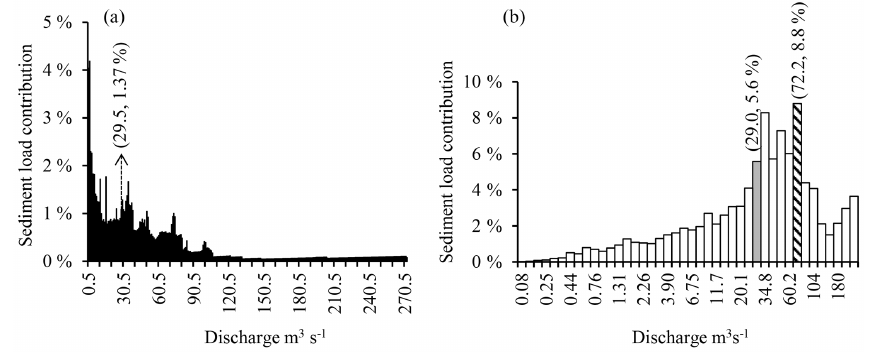
Figure 11. Sediment load histogram established using the sediment rating curve: for a subdivision into classes of equal amplitudes